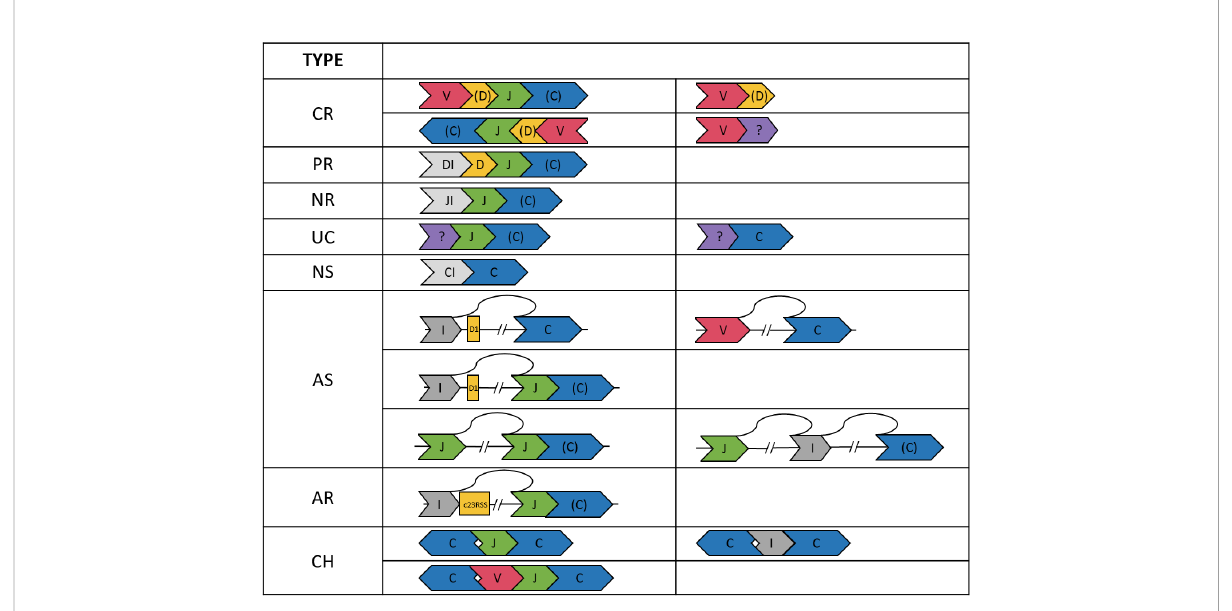
FIGURE 1 Illustration of the TCR b sequences in the eight categories. A segment in “ () ” , e.g., (D, C), may be absent. The DI, JI, and CI segments indicate introns upstream of the D, J, and C genes, respectively. The “ ? ” segment is unaligned. Arrows indicate strands of the